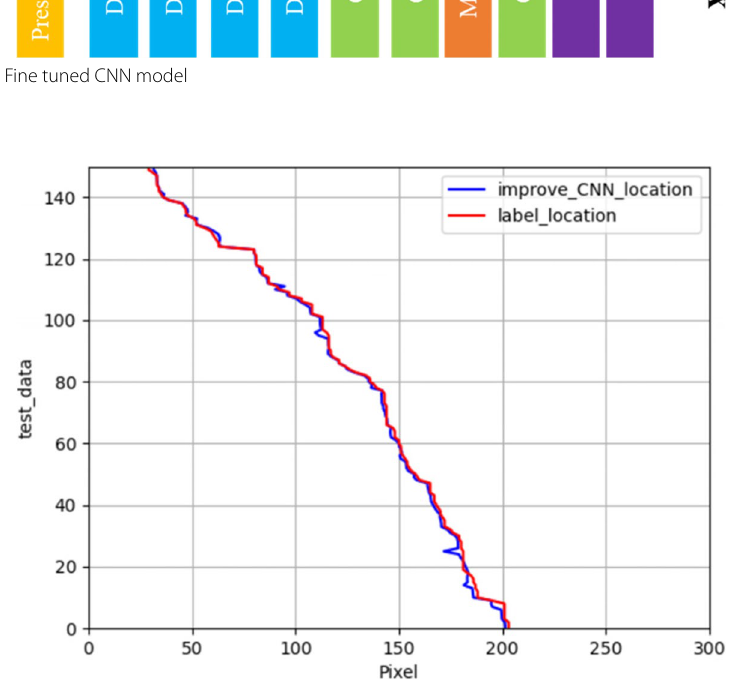
Fig. 14 Comparison of leading edge position between direct prediction based on improved CNN and